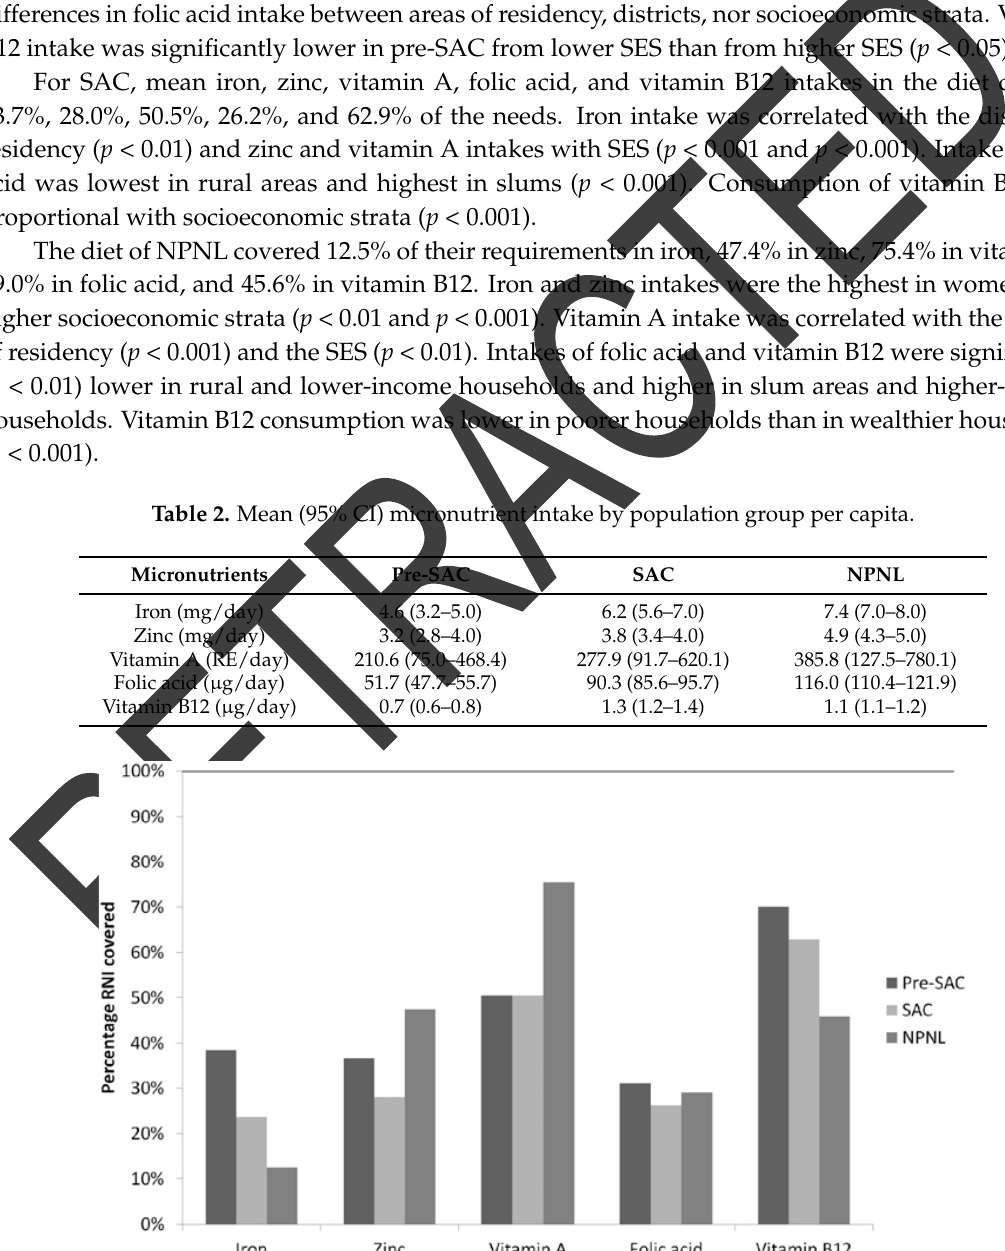
Table 2. Mean (95% CI) micronutrient intake by population group per capita.